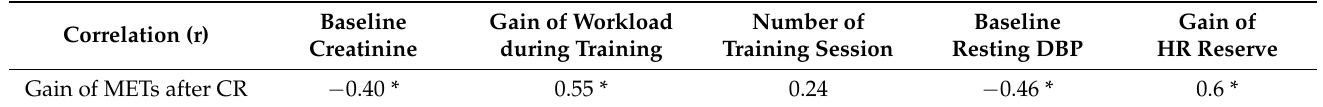
Table 3. Correlation gain of exercise capacity after endurance training